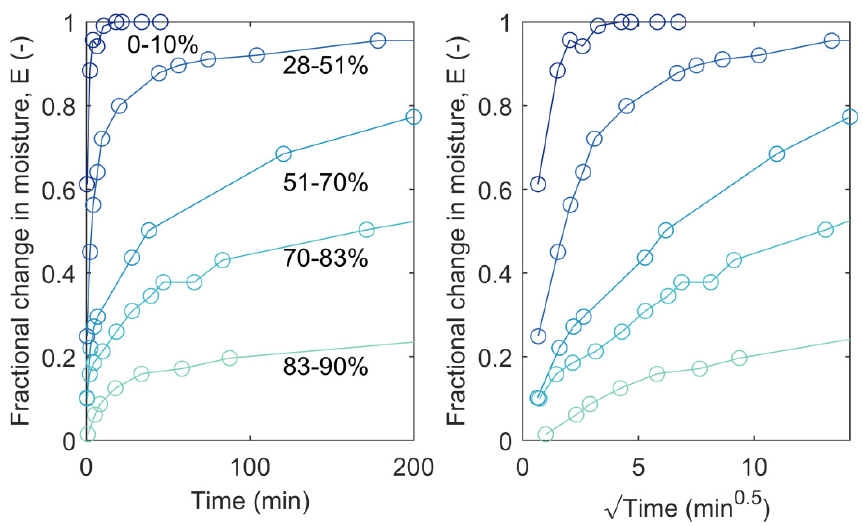
Figure 3. Absorption curves measured with a vacuum sorption balance for 20 µm tangential microtomed specimens of mountain ash ( Eucalyptus regnans F. Muell.) at different steps in relative humidity (RH) [40].